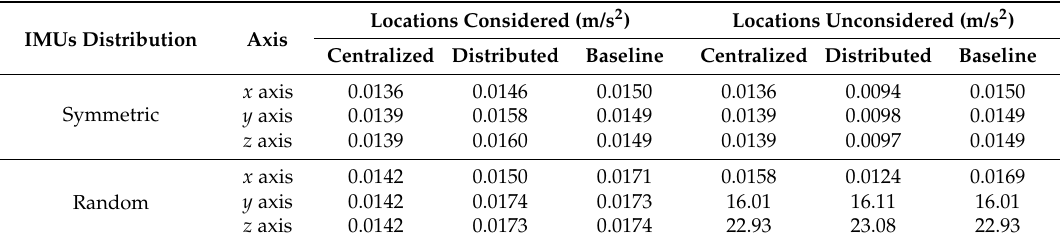
Table 1. Standard deviation of the acceleration estimation errors, for the symmetric and random 27 IMUs configurations within the 20 mm edges cube.